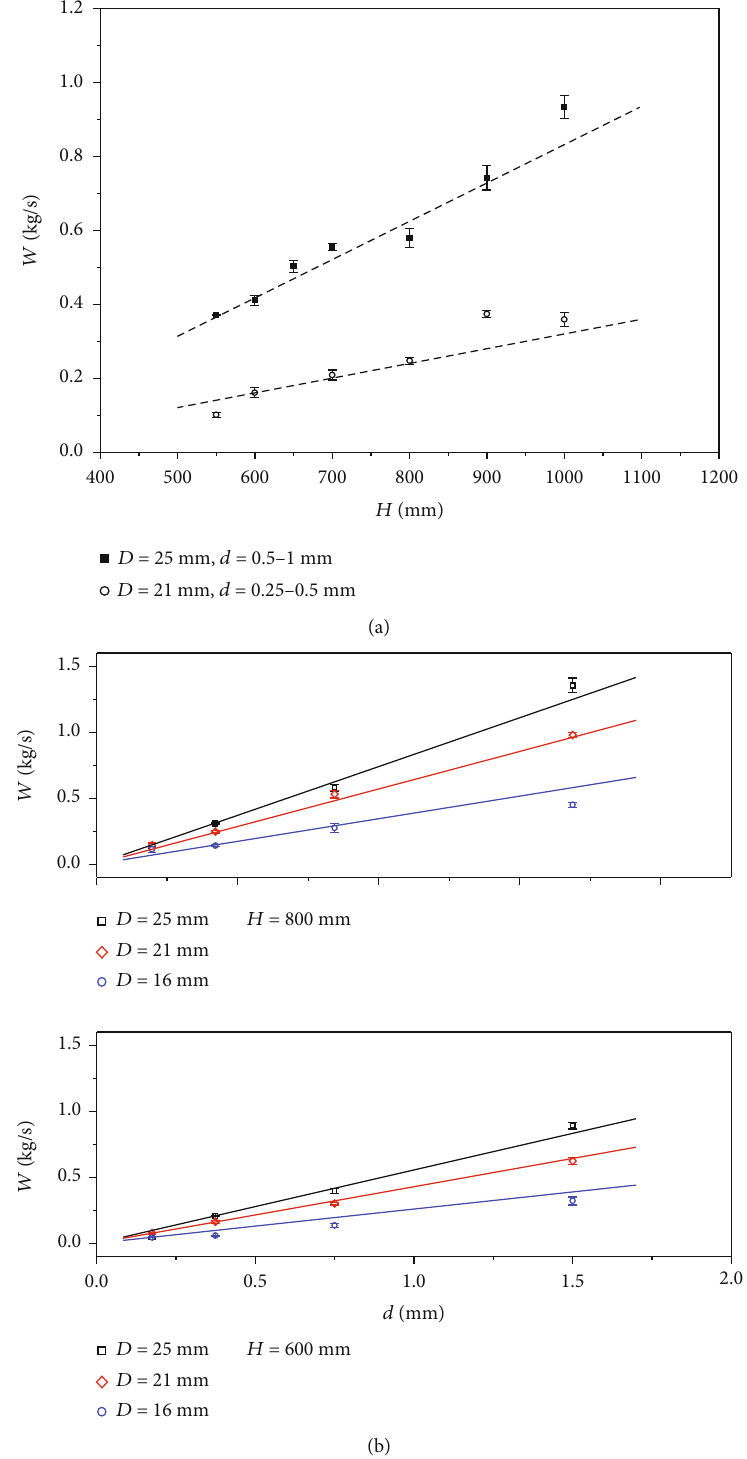
Figure 5: Mass fl ow rate at which sand and water are discharged versus (a) H and (b) the average diameter of the particles (dashed curves are calculated by using Equation